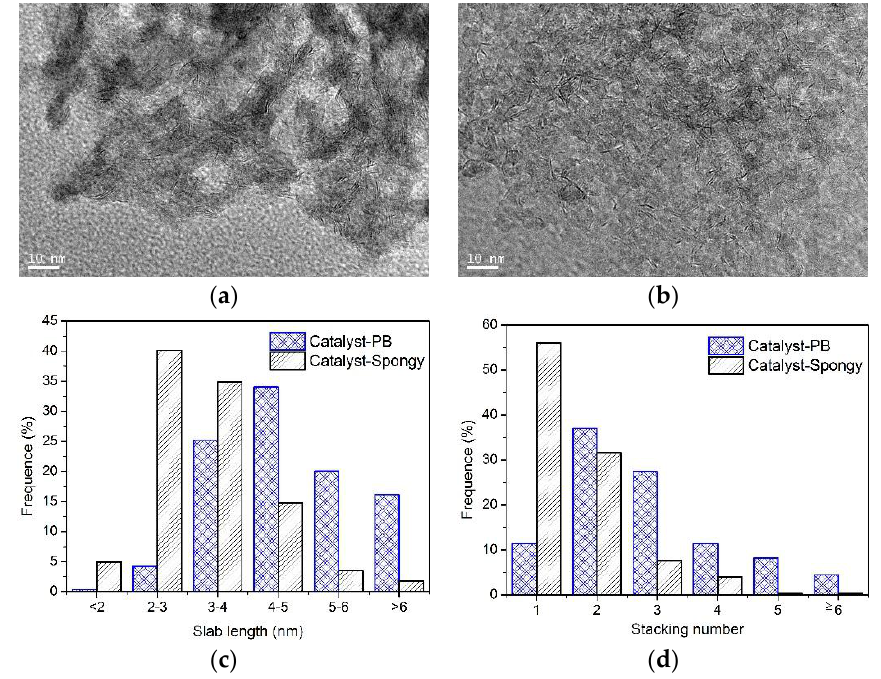
Figure 7. HRTEM images of sulfurized catalysts: ( a ) Catalyst-PB-S, ( b ) Catalyst-Spongy-S, and distributions of ( c ) slab length and ( d ) stacking number of MoS 2 slabs on sulfurized CoMo/Al 2 O 3 catalysts. — — Table 3. Average length (L), stacking layer numbers (N) and fraction of Mo atoms on the edge surface ( f Mo ) in sulfided catalysts.